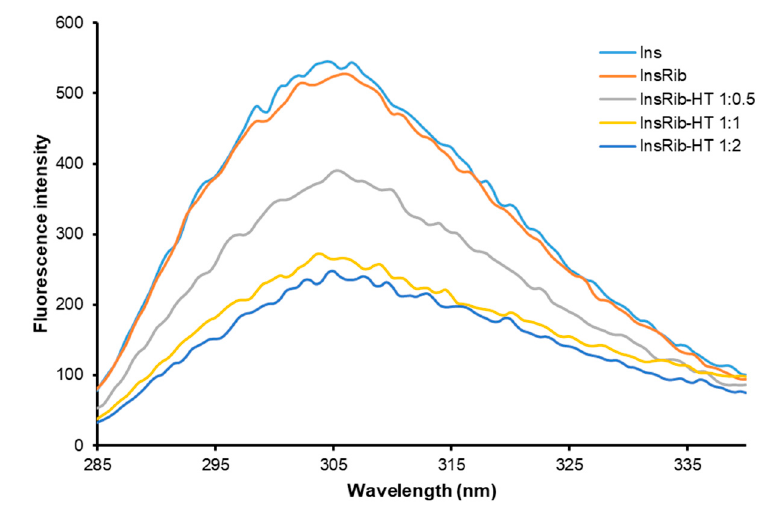
Figure 5. Glycated insulin-HT interaction monitored by intrinsic fluorescence spectroscopy. Tyrosine fluorescence emission has been detected in native insulin (Ins) and insulin glycated by D -ribose (InsRib) in the absence and in the presence of HT at different molar ratio (1:0, 1:0.5, 1:1, 1:2). Insulin working concentration was 10 µ M. Other experimental details are described in the Methods section.